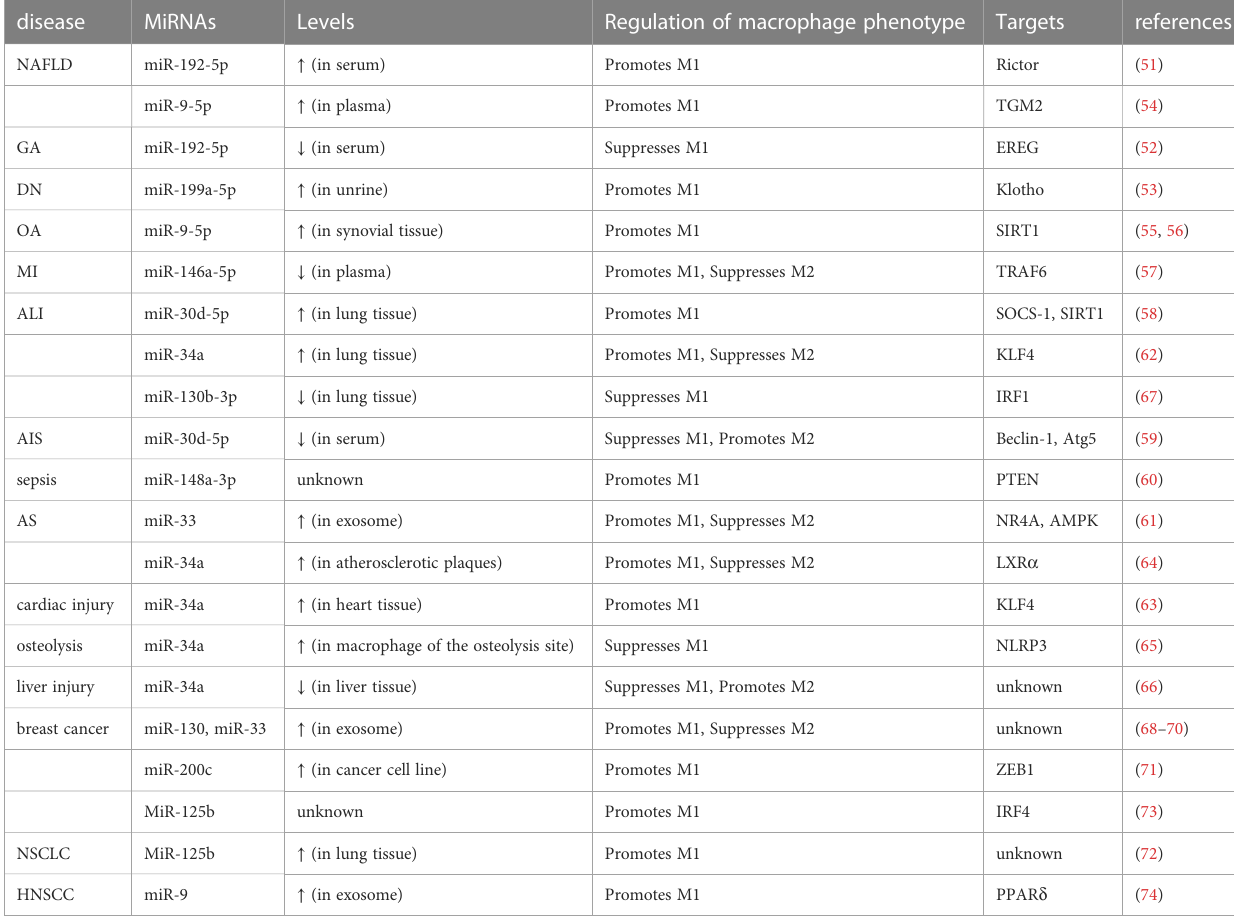
TABLE 1 M1 macrophage polarization by miRNAs in various